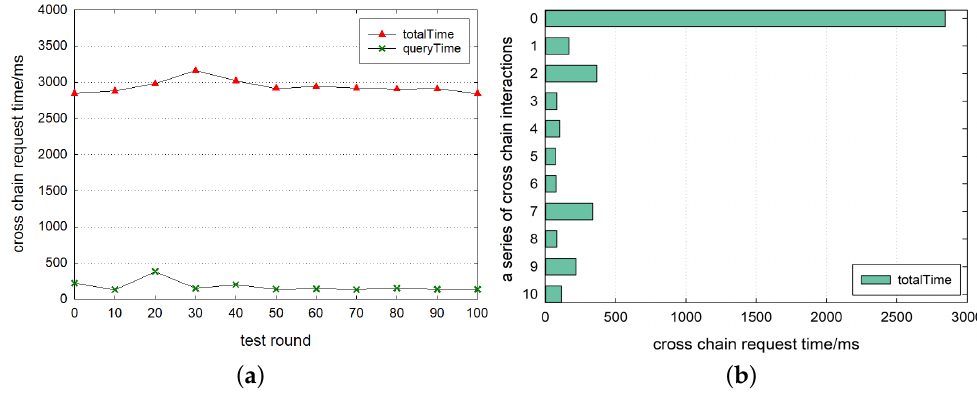
Figure 8. Unencrypted cross-chain time latency. ( a ) First cross-chain request tests and ( b ) a series of cross-chain request